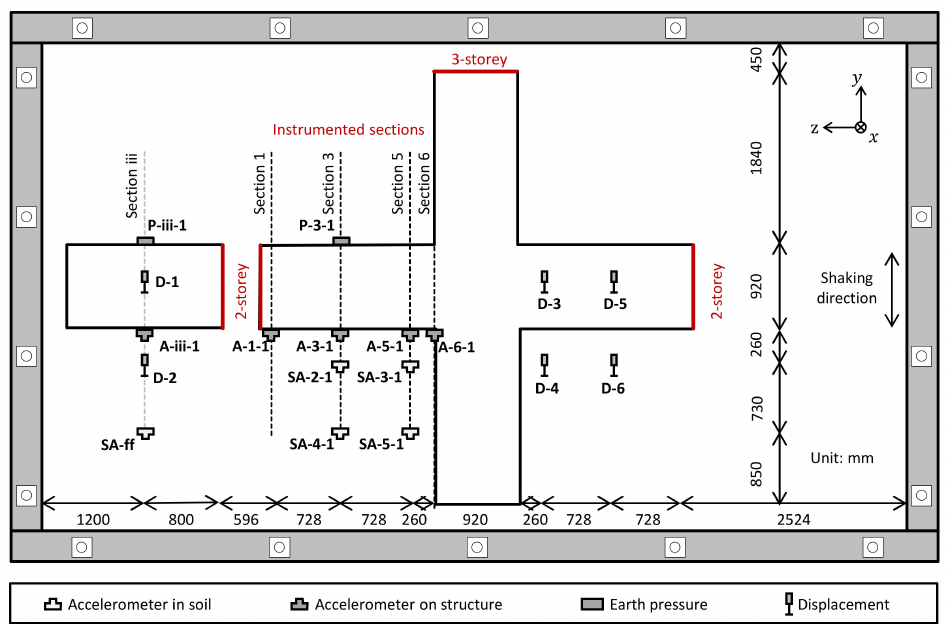
Figure 6. Layout of the experiment in the plane view, showing key dimensions and instrumentation with measurements expressed in mm.